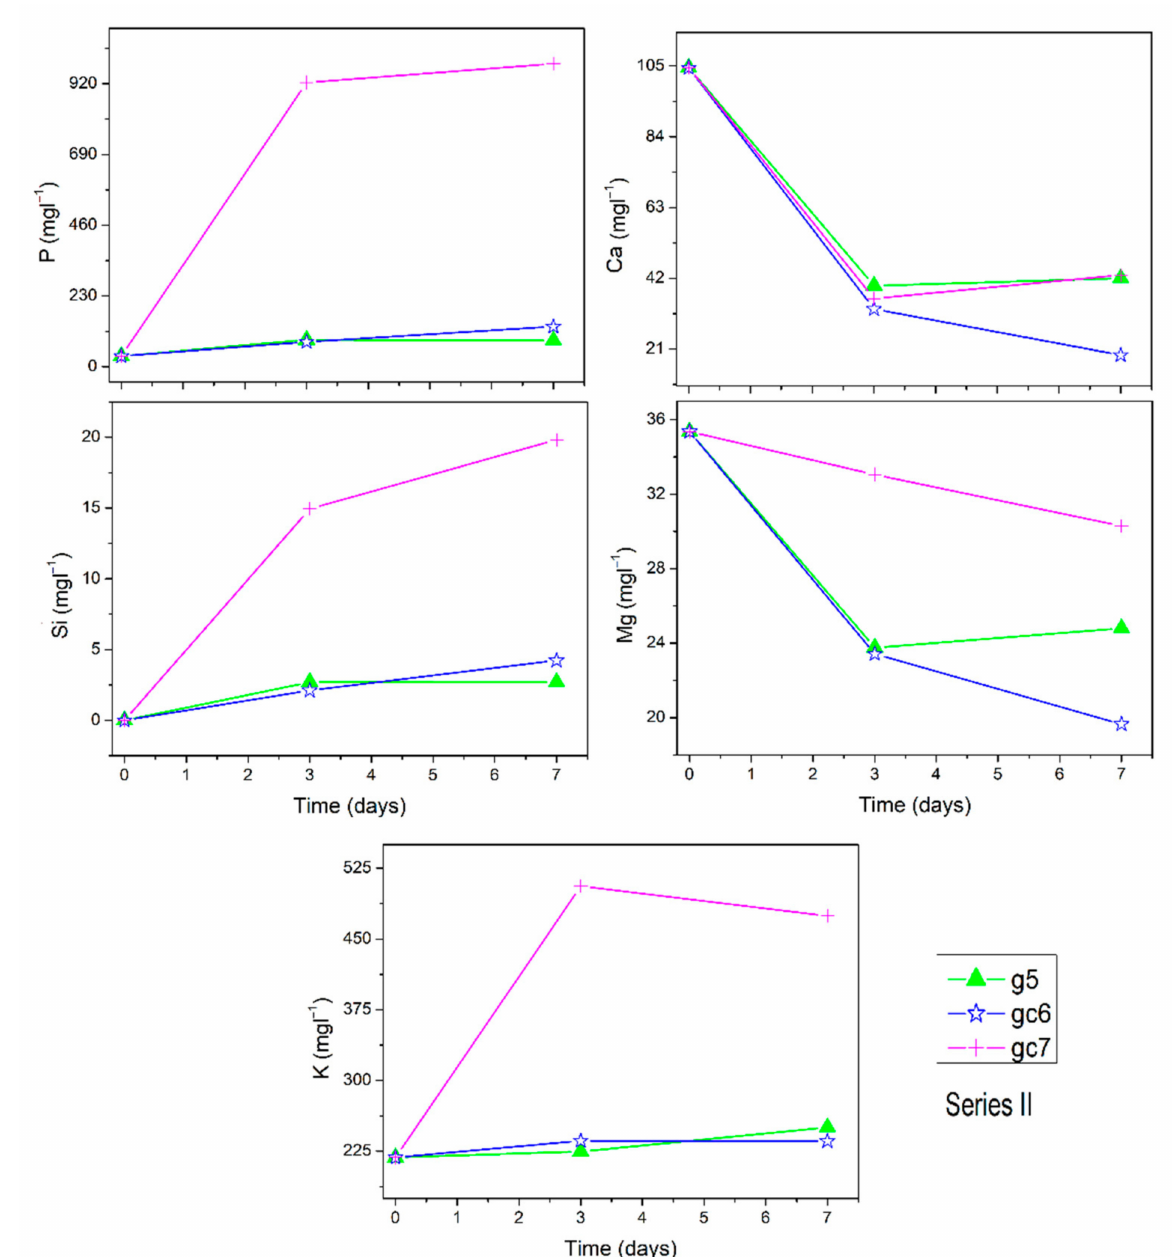
Figure 3. Ion dissolution profiles of series II samples in SBF under static conditions as function of immersion time. Error bars are included in the points’